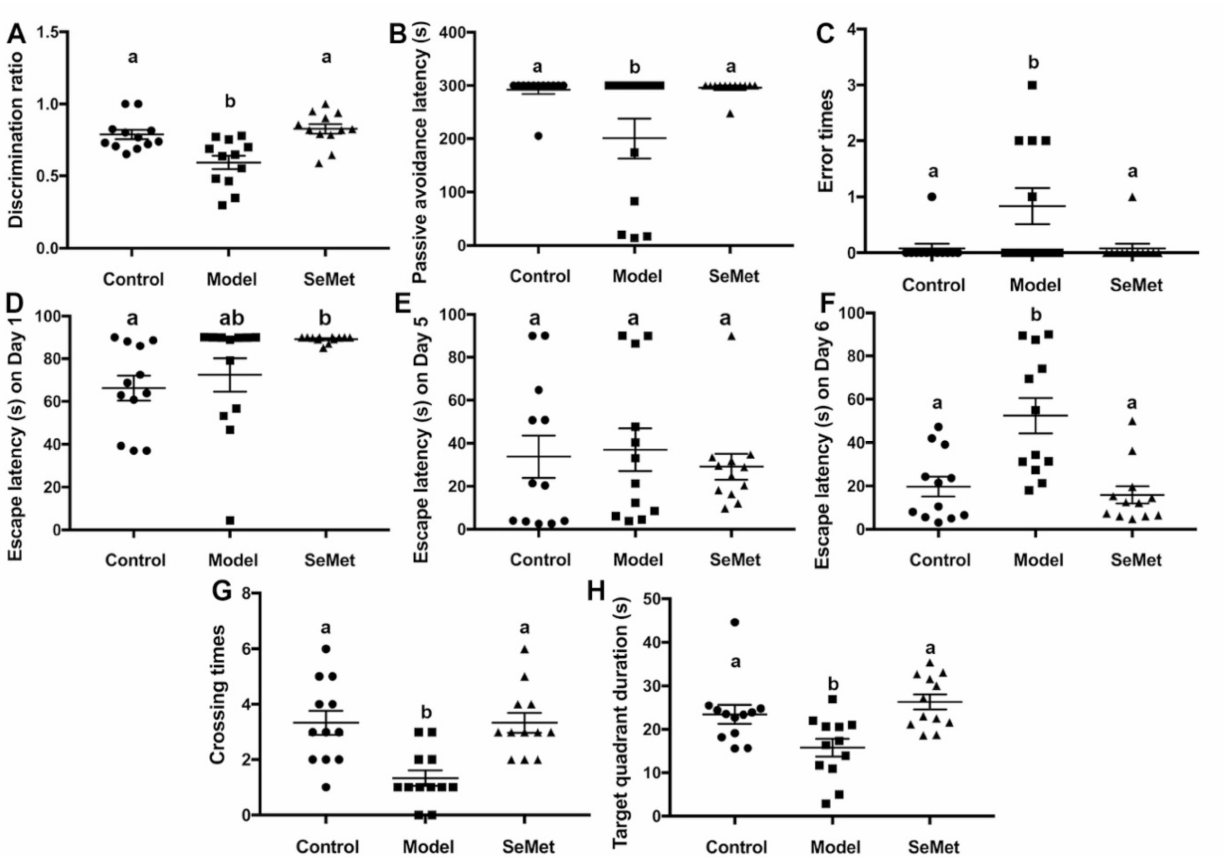
Figure 1. Effects of selenomethionine (SeMet) on cognitive impairment. ( A ) The discrimination ratio from novel object recognition test. ( B ) Passive avoidance latency and ( C ) error times from passive avoidance task. ( D – H ) Escape latency on Day 1 ( D ), Day 5 ( E ), and Day 6 ( F ), number of target crossings ( G ), and target quadrant duration ( H ) in the Morris maze test. The same letter within each column indicates no significant difference ( p >